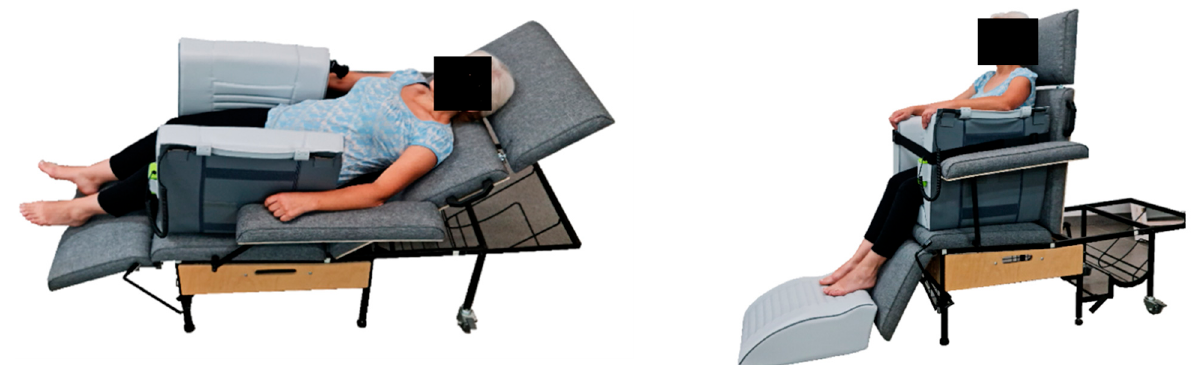
Figure 1. The positions of the participants during vibration treatments (authors’ own material). Table 1. Characteristics of the study groups.